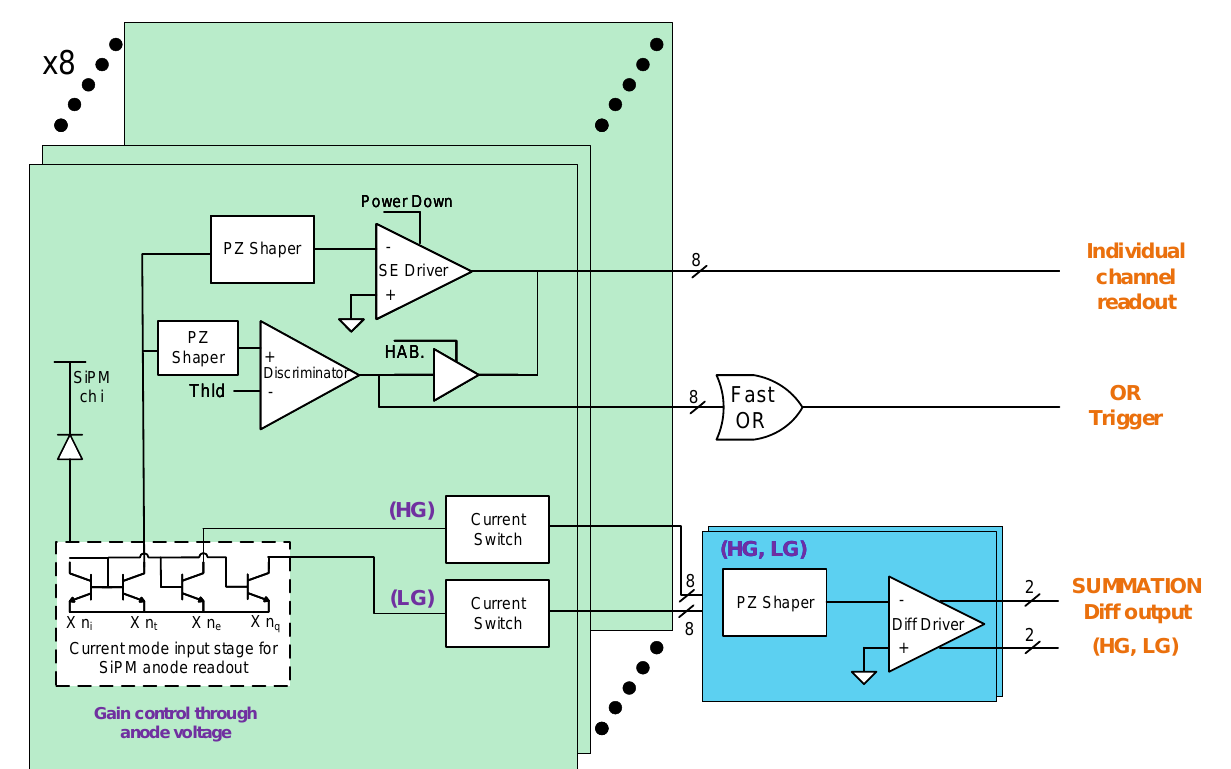
Figure 1. Multiple Use Silicon Photo − multiplier (SiPM) Integrated Circuit (MUSIC) functional block diagram. HG refers to high gain and LG to low gain signal